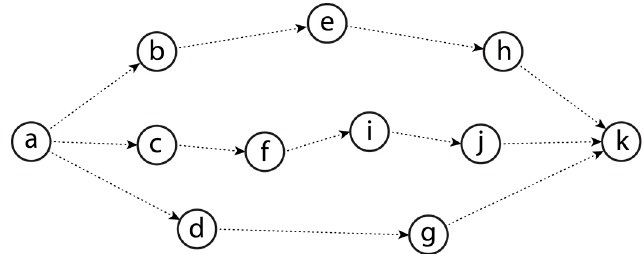
Figure 1. A sample opportunistic network (OppNet) consisting of 11 nodes.